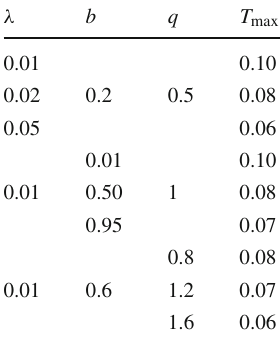
Table 1 The behavior of maximum temperature T max for various values of model